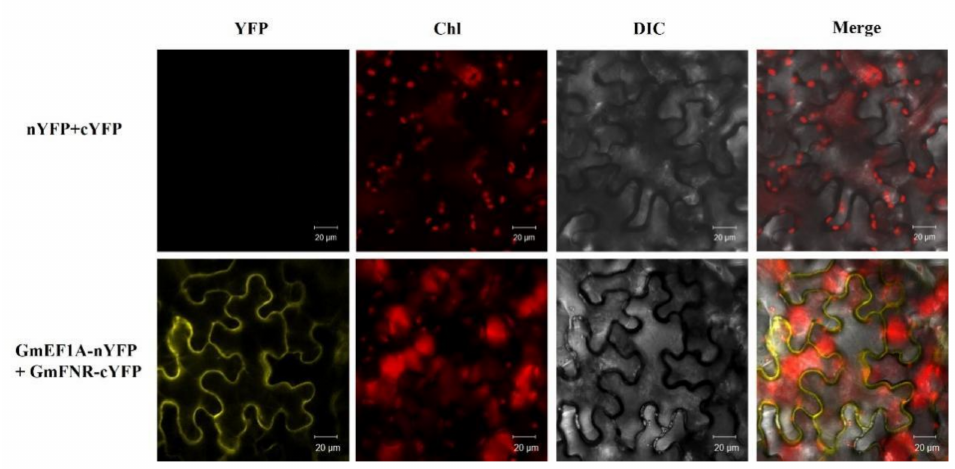
Figure 6. Bimolecular fluorescence complementation (BIFC)-interaction of GmFNR and GmEF1A. The C-terminal half and the N-terminal half of YFP were fused to GmFNR and GmEF1A. GmEF1A- nYFP and GmFNR-cYFP were co-transformed into Nicotiana Benthamiana leaves, with nYFP † cYFP as control. YFP fluorescence was detected using a confocal microscope after infection for 2 d. Bars indicate 20 µ m.